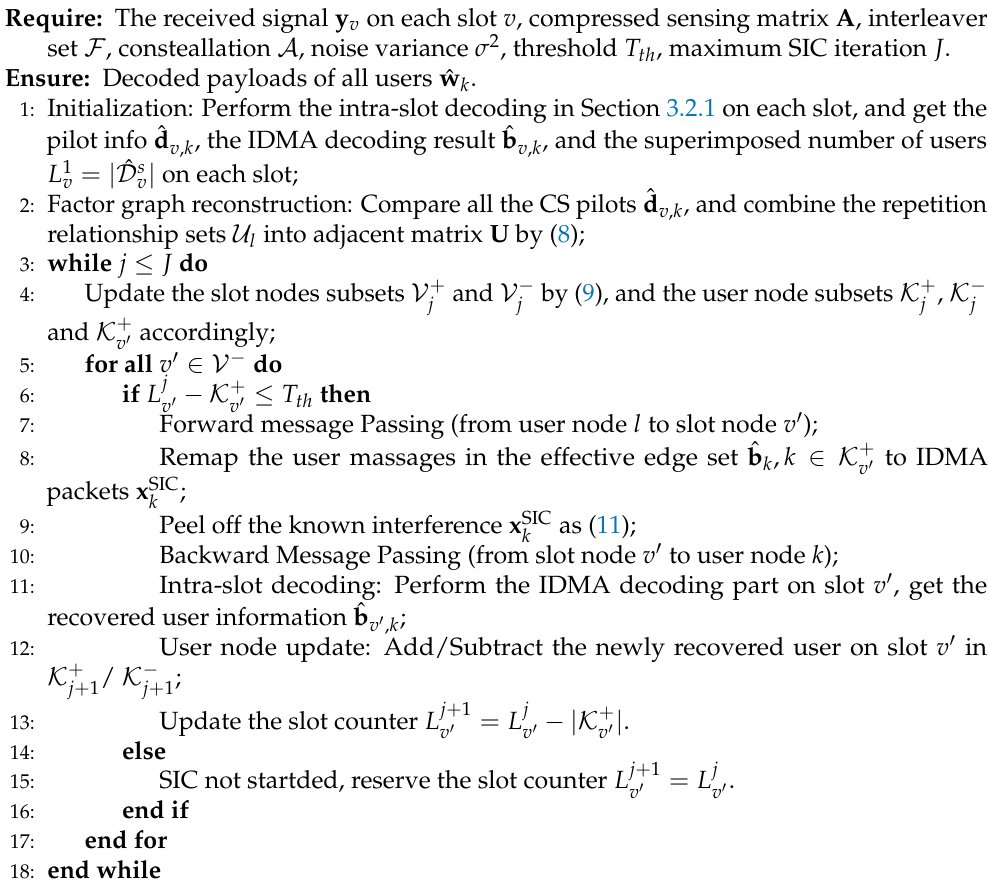
Algorithm 1 Inter-slot SIC decoding on the compound packet-level factor